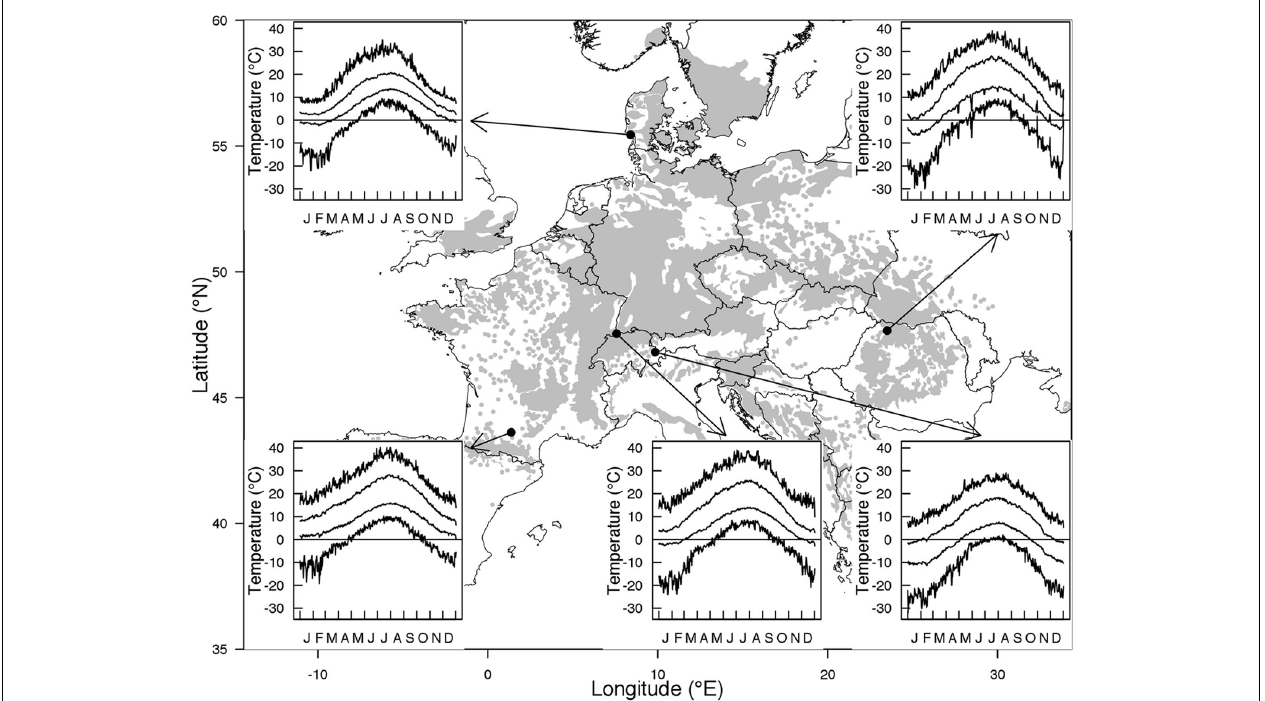
FIGURE 1 | Distribution range of Fagus sylvatica along with climatic characteristics at the northern and southern edge of the distribution and at low versus high elevation in central Europe. Absolute maximum, mean maximum, mean minimum, and absolute minimum temperature for a given day of the year in the period 1901–2000 are shown.The selected